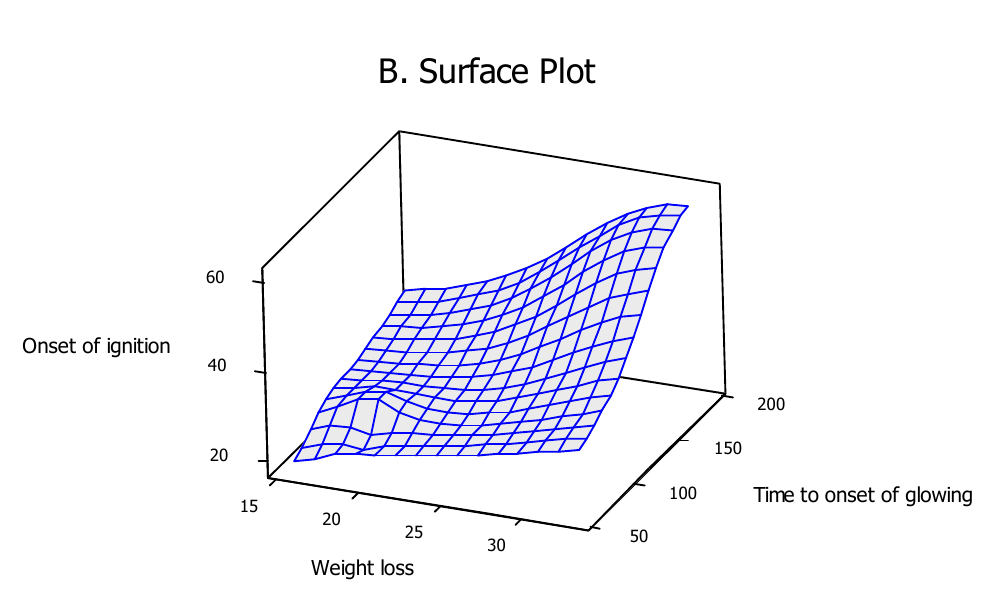
Figure 8. Contour ( A ) and surface plots ( B ) among fire properties of weight loss versus times to onset of glowing and ignition.